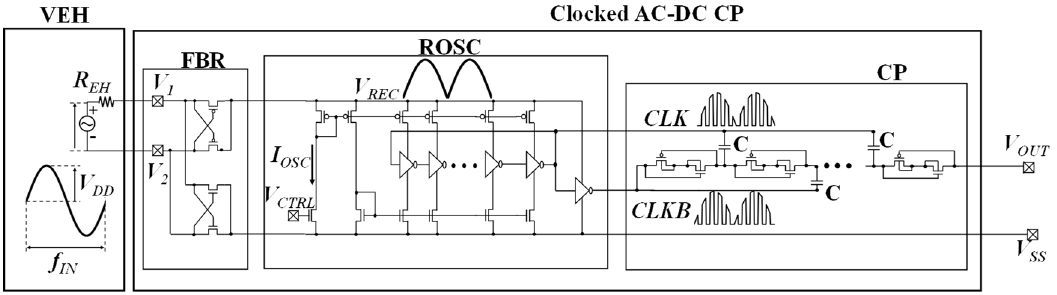
Figure 8. System diagram of the clocked AC-DC CP.